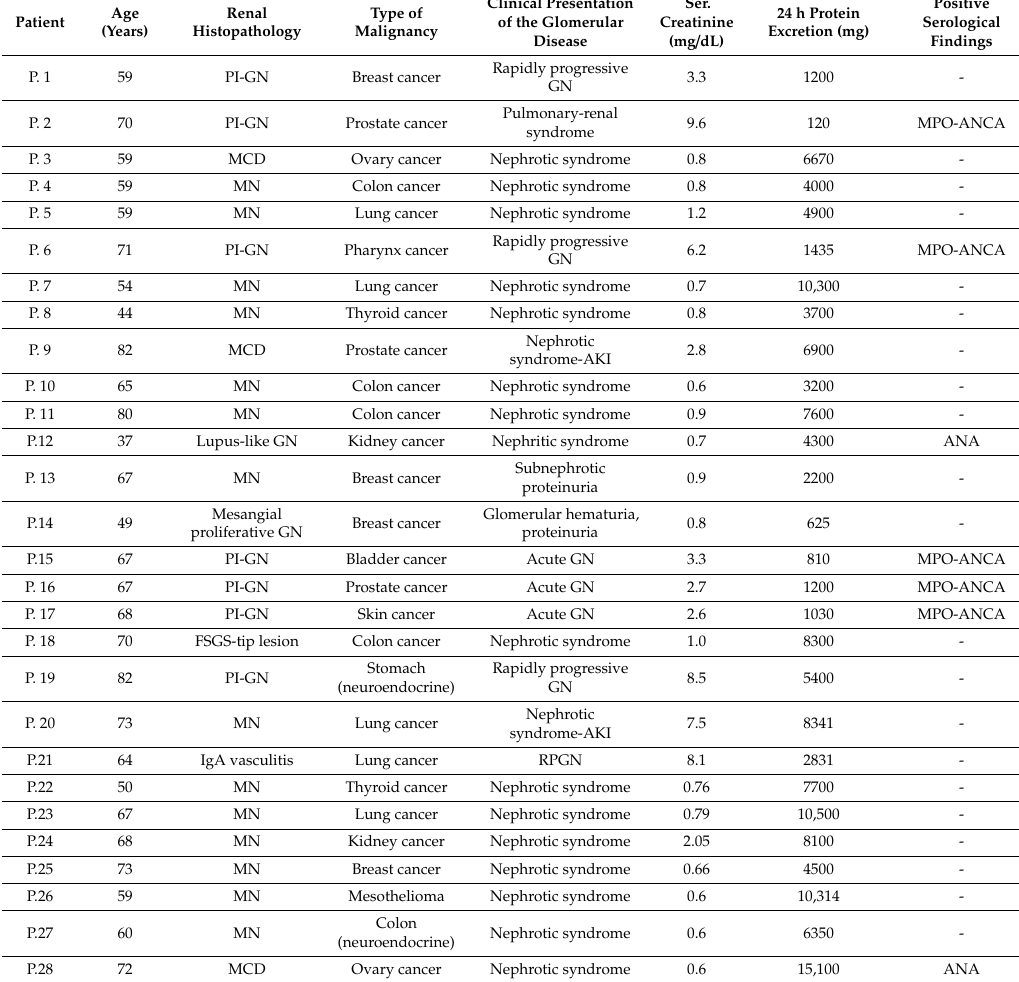
Table 2. Characteristics of the patients with GD associated with solid